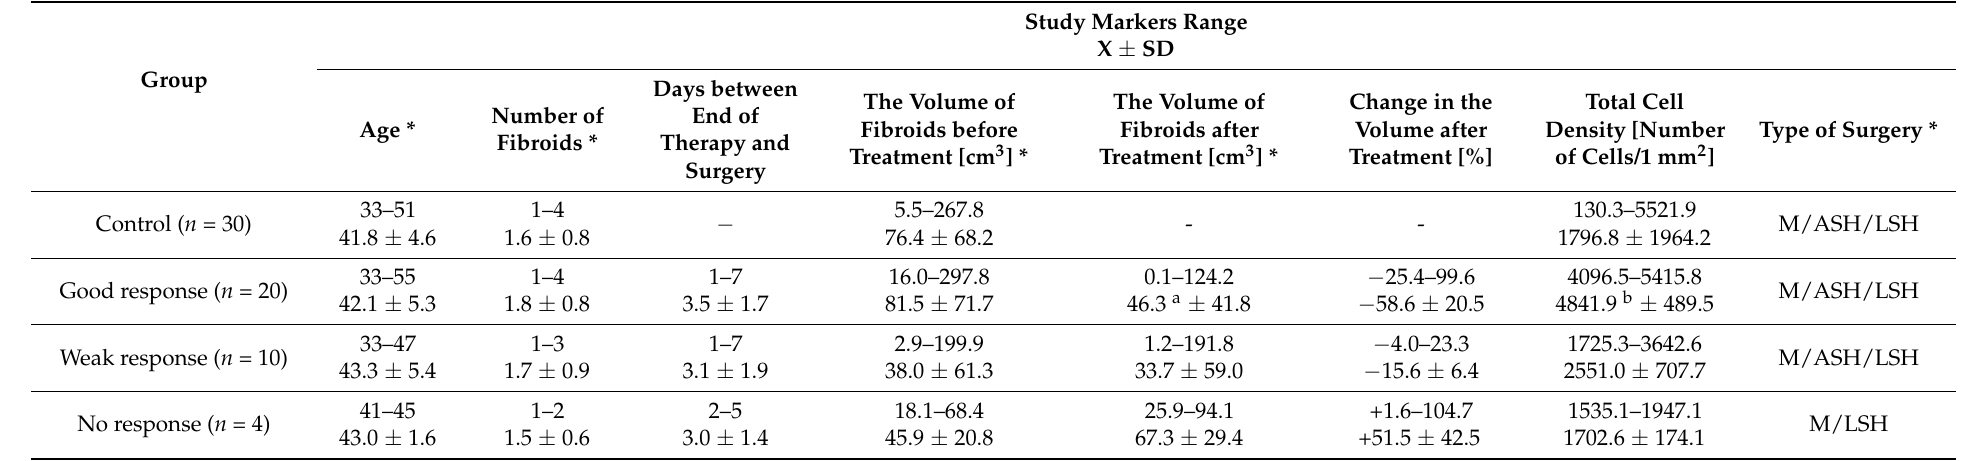
Table 1. Demographic and clinical characteristic of the